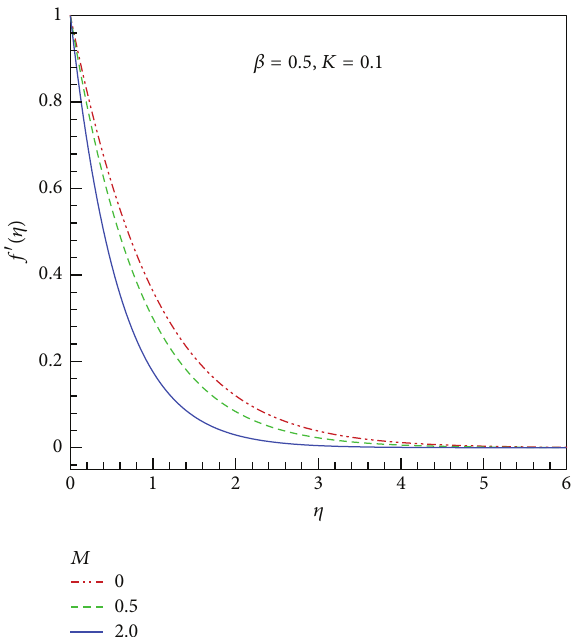
Figure 2: Effect of magnetic parameter on dimensionless velocity for 𝛽 = 0.5 , 𝐾 = 0.1